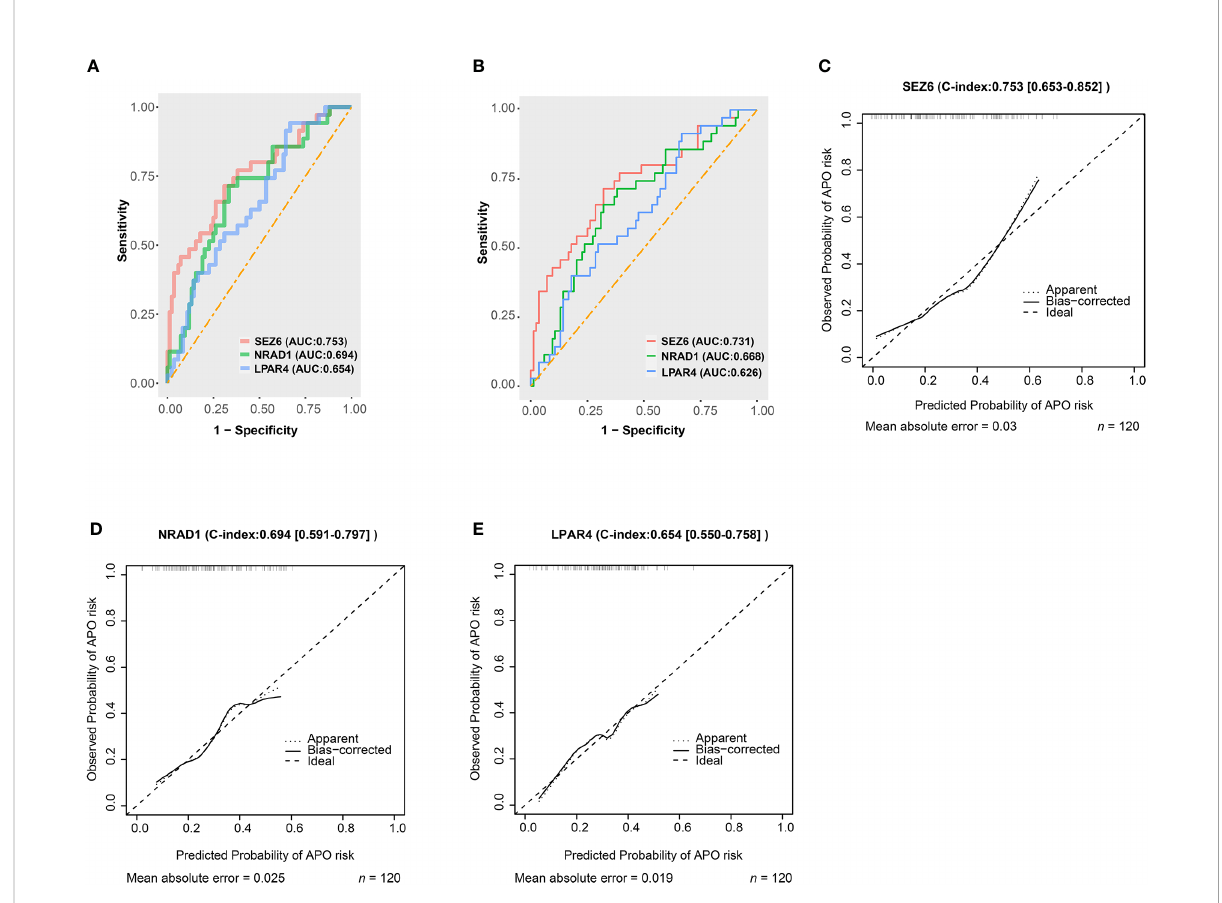
FIGURE 4 Predictive abilities for SEZ6 , NRAD1 , and LPAR4 . (A) The ROC curve of SEZ6 , NRAD1 , and LPAR4 for predicting APO risk in women with SLE during early and mid-pregnancy. (B) The Leave-one-out-cross-validation ROC curve of SEZ6 , NRAD1 , and LPAR4 for predicting APO risk in women with SLE during early and mid-pregnancy. (C – E) The calibration curves for SEZ6 (C) , NRAD1 (D) and LPAR4 (E) for predicting APO risk in women with SLE during early and